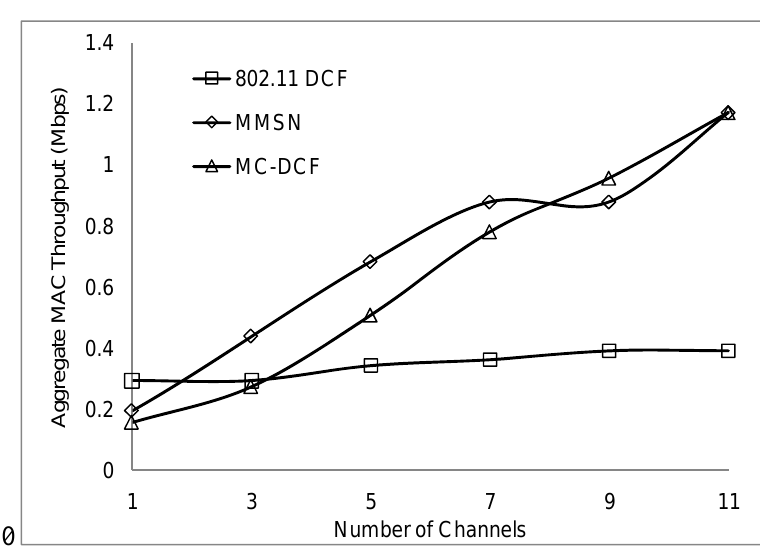
Figure 7. Throughput impact on